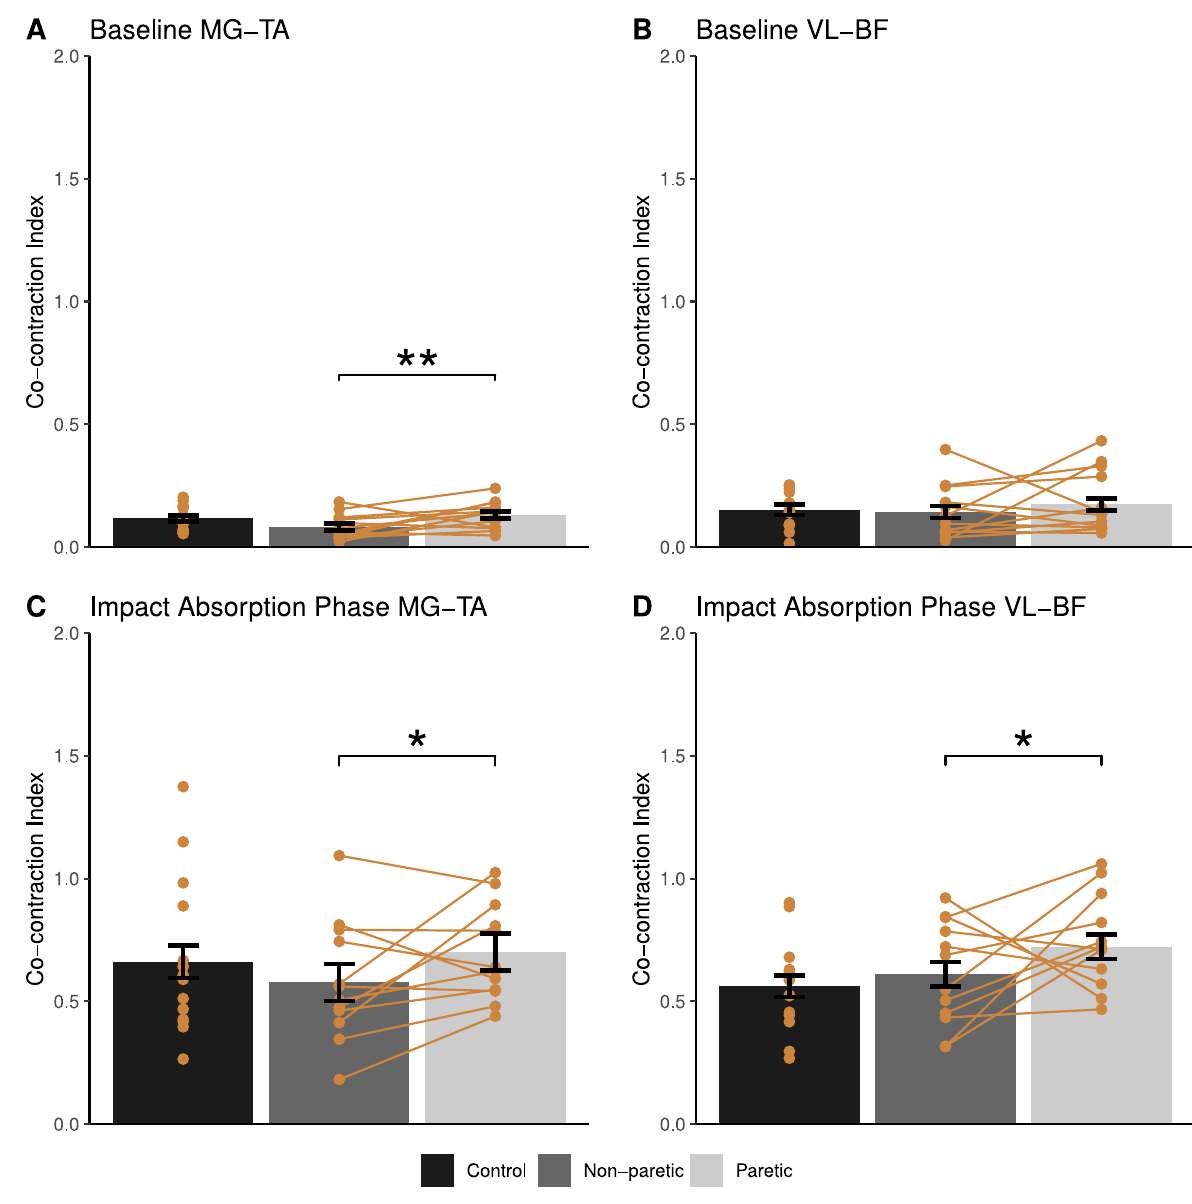
Figure 6. Between-group comparison of ( A ) Medial Gastrocnemius (MG) and Tibialis Anterior (TA) muscle co-contraction index during baseline, ( B ) Vastus Lateralis (VL) and Bicep Femoris (BF) muscle co-contraction index during baseline, ( C ) MG and TA muscle co-contraction index during the impact absorption phase, and ( D ) VL and BF muscle co-contraction index during the impact absorption phase (mean ± standard error). Yellow points show data from individual participants, and data from the same participant are linked with yellow lines. *p < 0.05, **p < p = 0.04 for knee; Fig. 6C,D). Higher co-contraction index during baseline was also found at the paretic ankle but not the knee joint compared to the non-paretic side (p < 0.01; Fig. 6A,B). Peak paretic ankle rate of energy absorption during induced limb loading was correlated with walking speed (R 2 = 0.39, p = 0.029) and double support duration (R 2 = 0.37, p = 0.036) when walking at maximum walking speed in participants with chronic stroke. No correlation was found between peak paretic ankle rate of energy absorption and speed or double support duration when walking at a self-selected speed. No significant correlation was found between peak ankle rate of energy absorption at the non-paretic limb and speed or double support duration when walking with self-selected or maximum walking speed (Fig. 7).